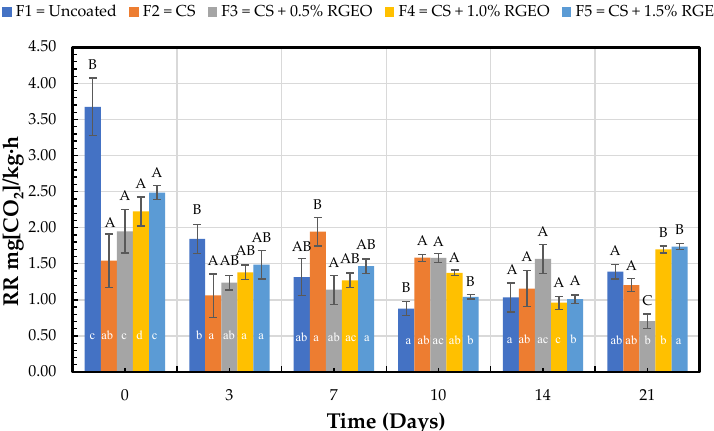
Figure 5. CO 2 respiration rate in pears with CS + RGEO treatments: F1 = control, F2 = CS, F3 = CS + RGEO 0.5%, F4 = CS + RGEO 1.0%, and F5 = CS + RGEO 1.5%. According to the ANOVA test, mean values and intervals of Duncan test for treatments and Fisher for days with 95%. Different lowercase letters (a, b, c) indicate significant differences between days according to the LSD Fisher test for each treatment in a confidence interval of 95%. In contrast, different uppercase letters (A, B, C) indicate significant differences between treatments for each day according to the Duncan test in a confidence interval of